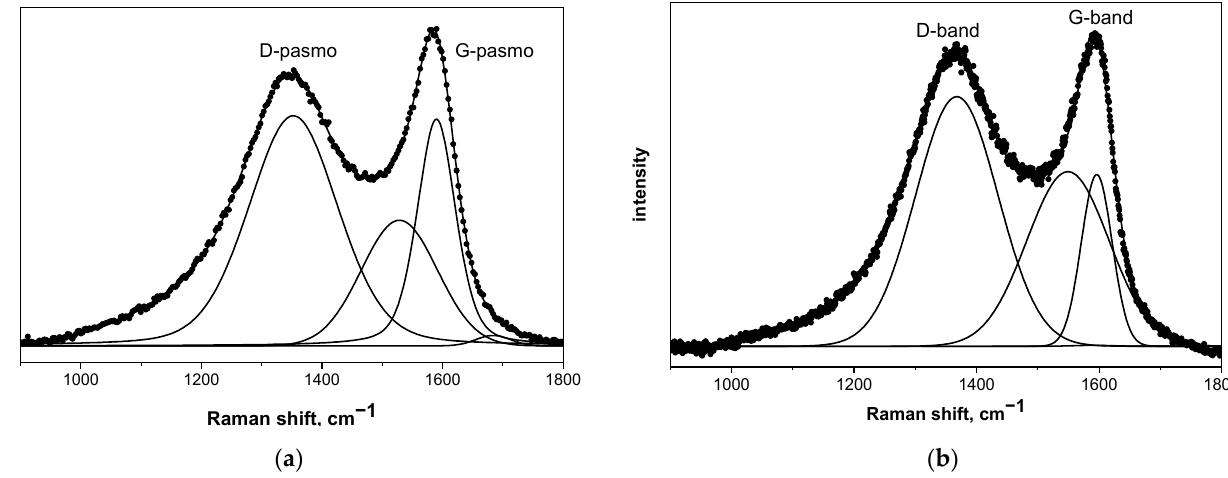
Figure 3. Deconvolution of the Raman spectra of ( a ) HES and ( b ) precursor prepared from a mixture of lyophilized HES and boric acid both pyrolyzed at 850 °C. Table 1. Position of the D- and G-bands, their intensity, and I D /I G ratio for pure saccharides and the precursors recrystal- lized, freeze-dried, and pyrolyzed at 800 °C for 1 h [16].